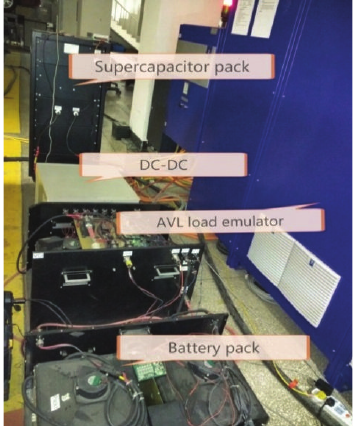
Figure 13: Hardware power